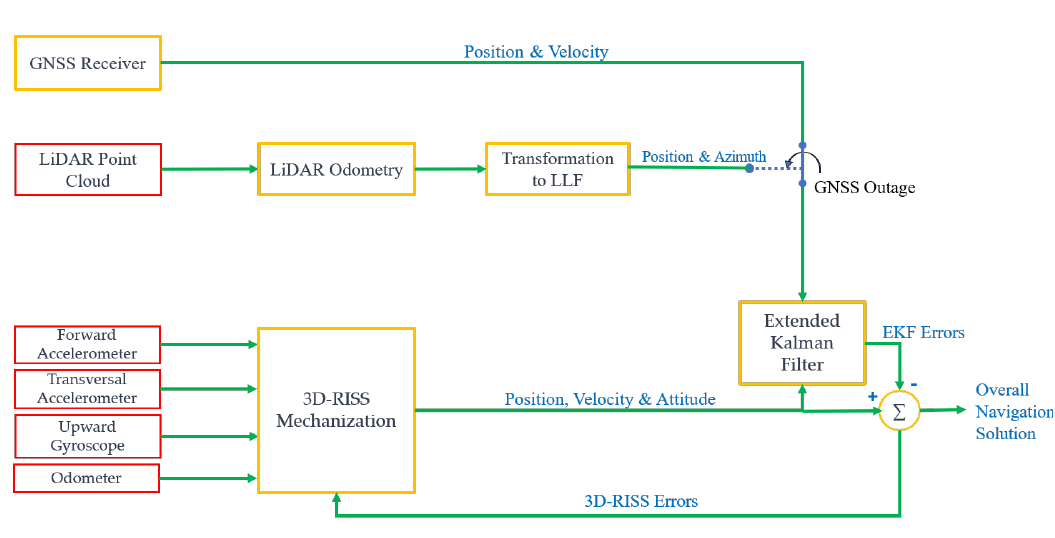
Figure 10. LiDAR/RISS/GNSS System Architecture. Figure 10. LiDAR / RISS / GNSS System